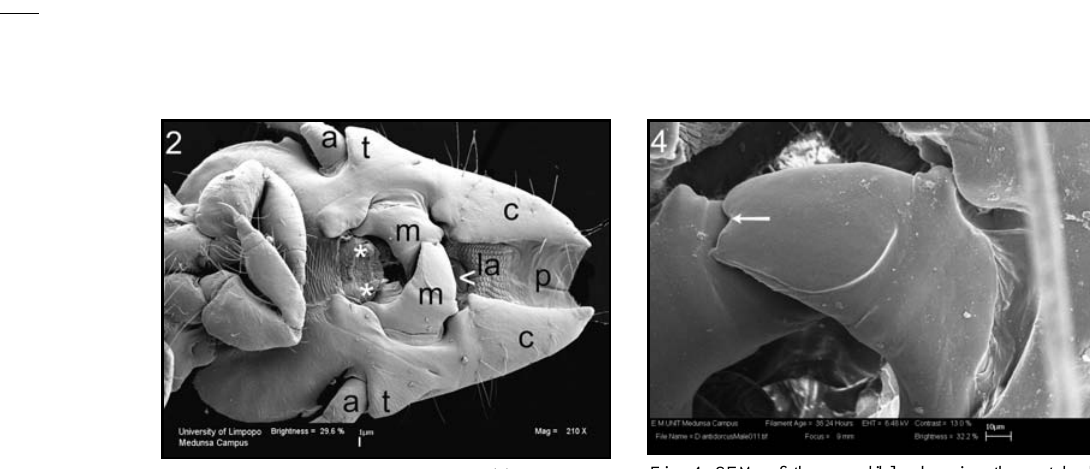
Fig. 2. The ventral aspect of the head, (a) first anten- nal segment, (c) clypeus, (la) labrum, (m) mandibles, (p) pulvinus, (t) trabecular region, (arrow) epipharynx, (*) labial palpi.